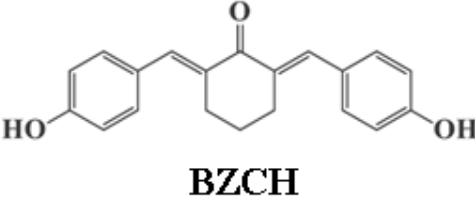
Figure 1. Chemical structure of 2,6-bis(4-hydroxybenzylidene) cyclohexanone